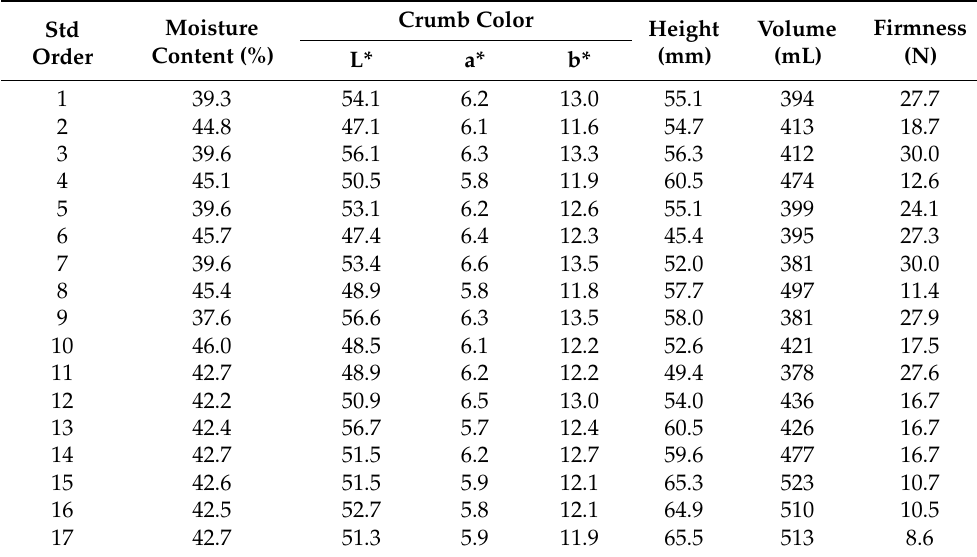
Table 4. Quality characteristics of bread prepared with flour–bran blend based on RSM.